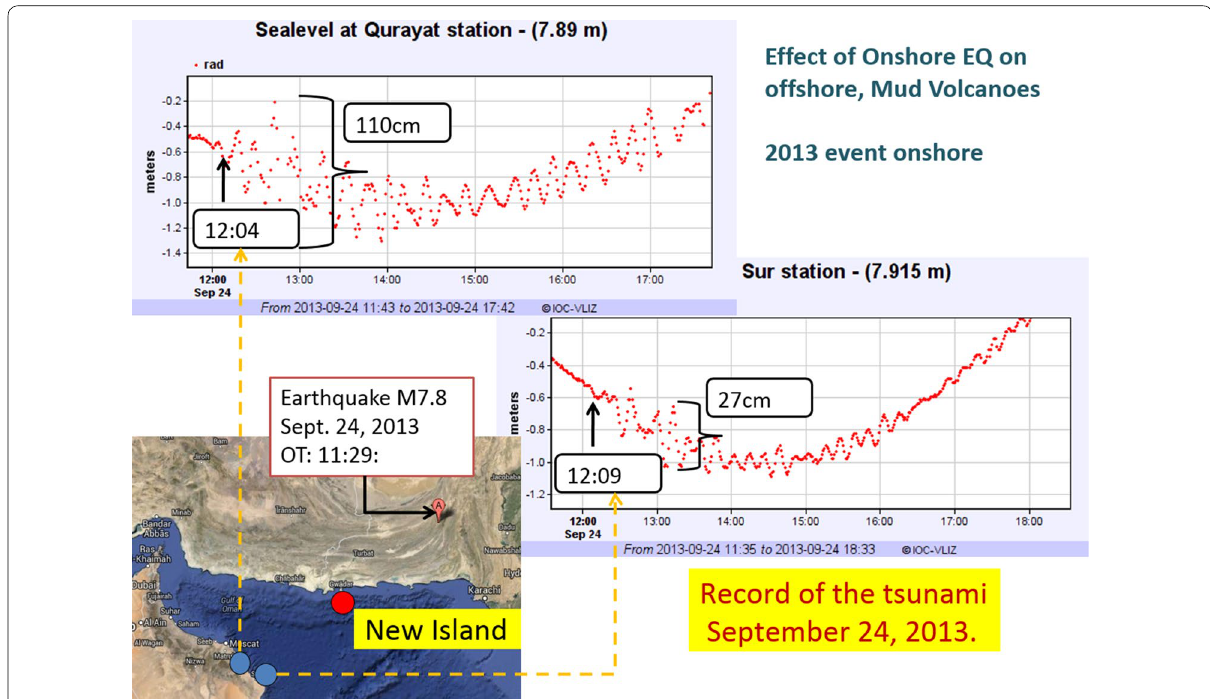
Fig. 3 Record of 2013 onshore earthquake and generation of Mud Volcano Island off Pakistan (Red dot) offshore Makran